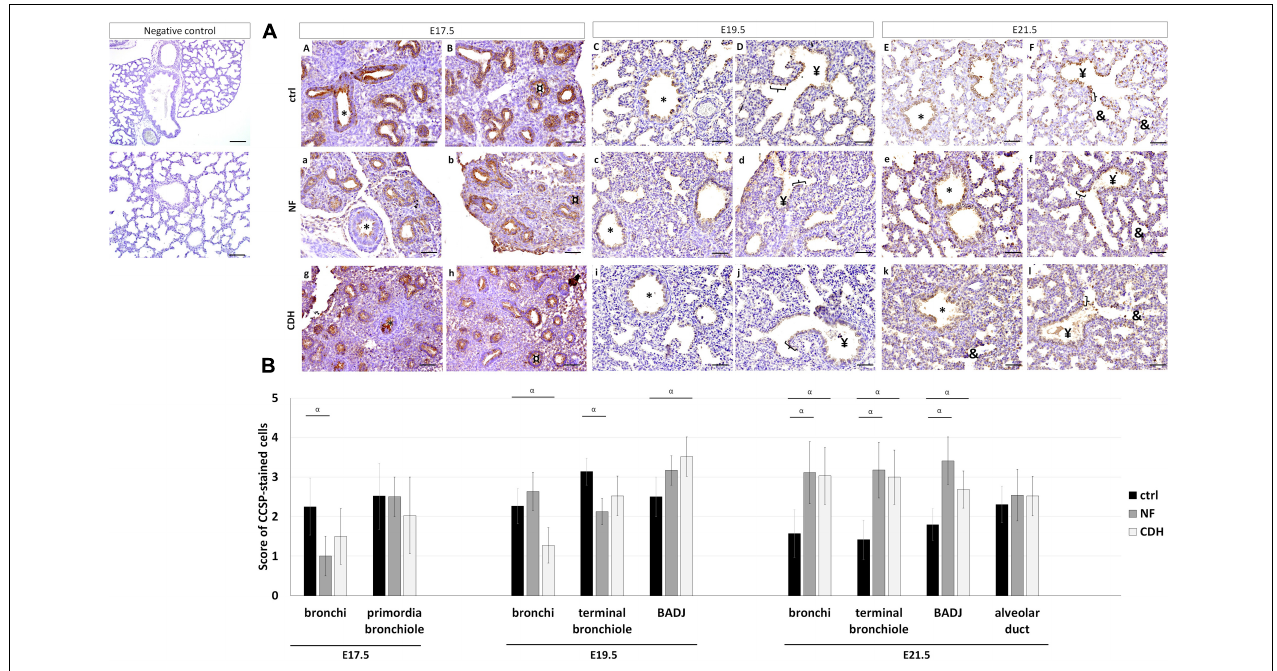
FIGURE 2 | Clara cell secretory protein (CCSP) expression pattern during normal and hypoplastic fetal lung development. Representative immunohistochemical evidence for CCSP expression at (AA,B,a,b,g,h) pseudoglandular, (AC,D,c,d,i,j) canalicular, and (AE,F,e,f,k,l) saccular stages in normal (ctrl), nitrofen (NF), and congenital diaphragmatic hernia (CDH) lungs, respectively. *Bronchiole; ¤primordia of bronchiole; yen terminal bronchiole; [bronchioalveolar duct junction; & alveolar duct. Scale bar 50 µ M. (B) Semi-quantitative analysis of CCSP expression from embryonic day (E) 17.5-to-E21.5 in normal, NF, and CDH lungs. Data are presented as mean ± SD. Symbols indicate the main effects and non-redundant interactions of T -test for independent samples. α p <